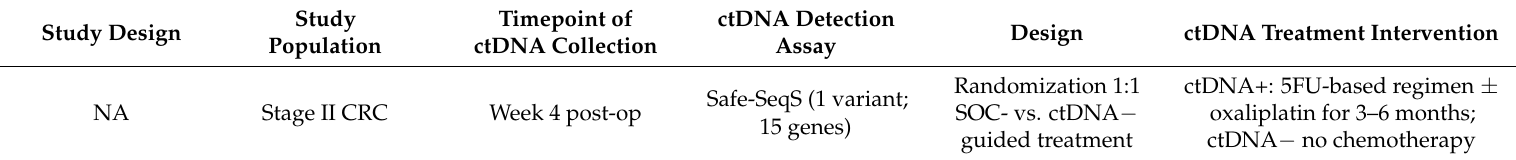
Table 3. ctDNA − guided ongoing clinical trials in early-stage colorectal